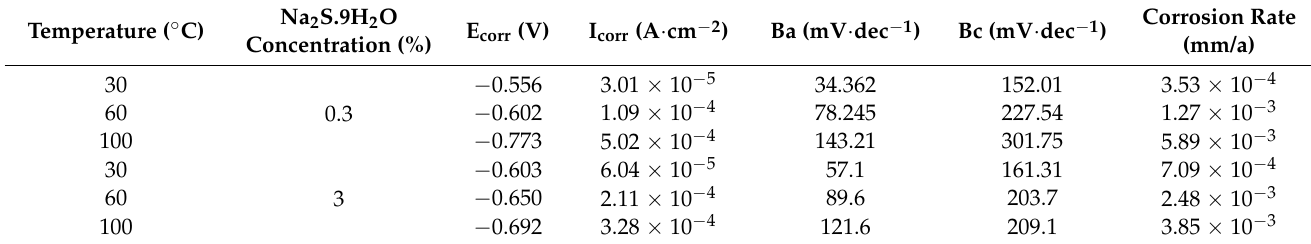
Table 7. Parameters for fitting the dynamic potential polarization curve of 80S